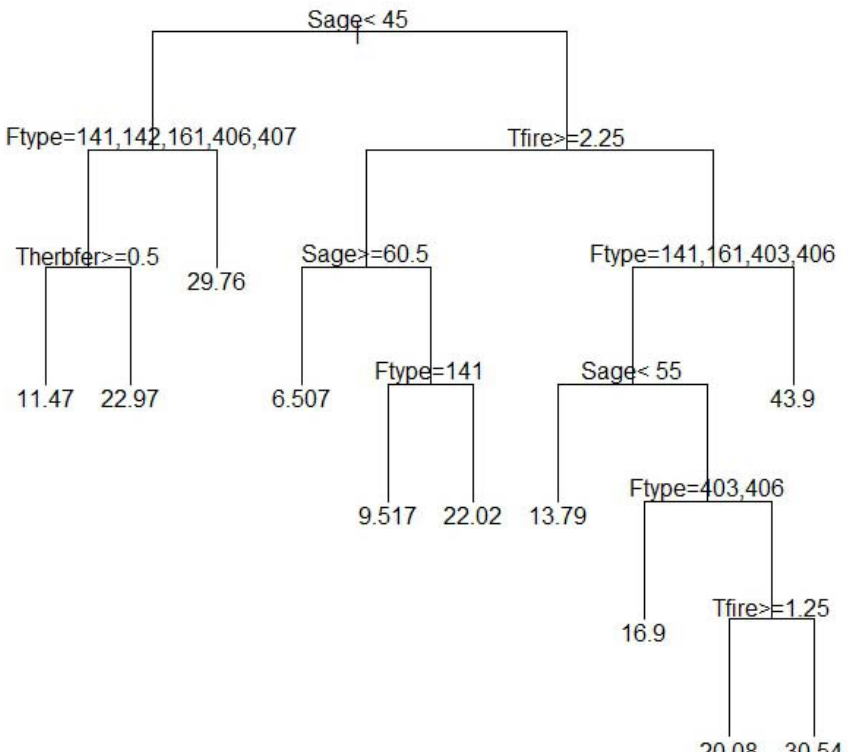
Figure 3. A regression tree for predicting understory herbaceous richness in pine forests of the southeastern coastal plain US. Sage = Stand age, Ftype = Forest type, Tfire = Time since last fire, Therbfer = Time since herbicide and fertilization. Values at the end of each terminal node are richness per 4 m 2